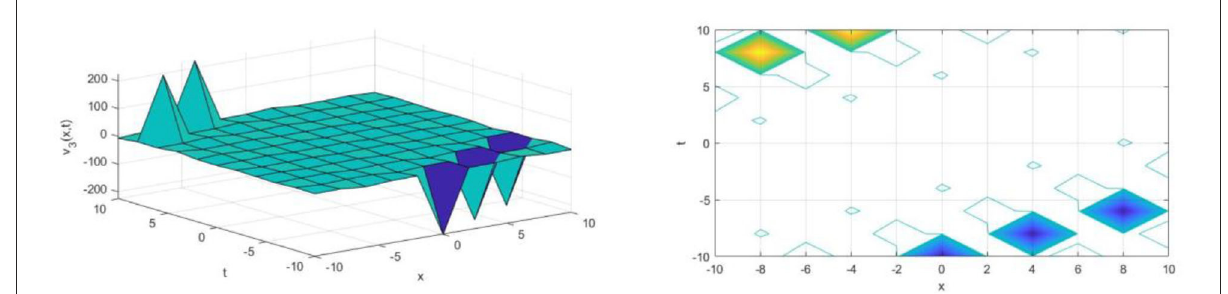
FIGURE7 The periodic wave solution of in 3D and contour.